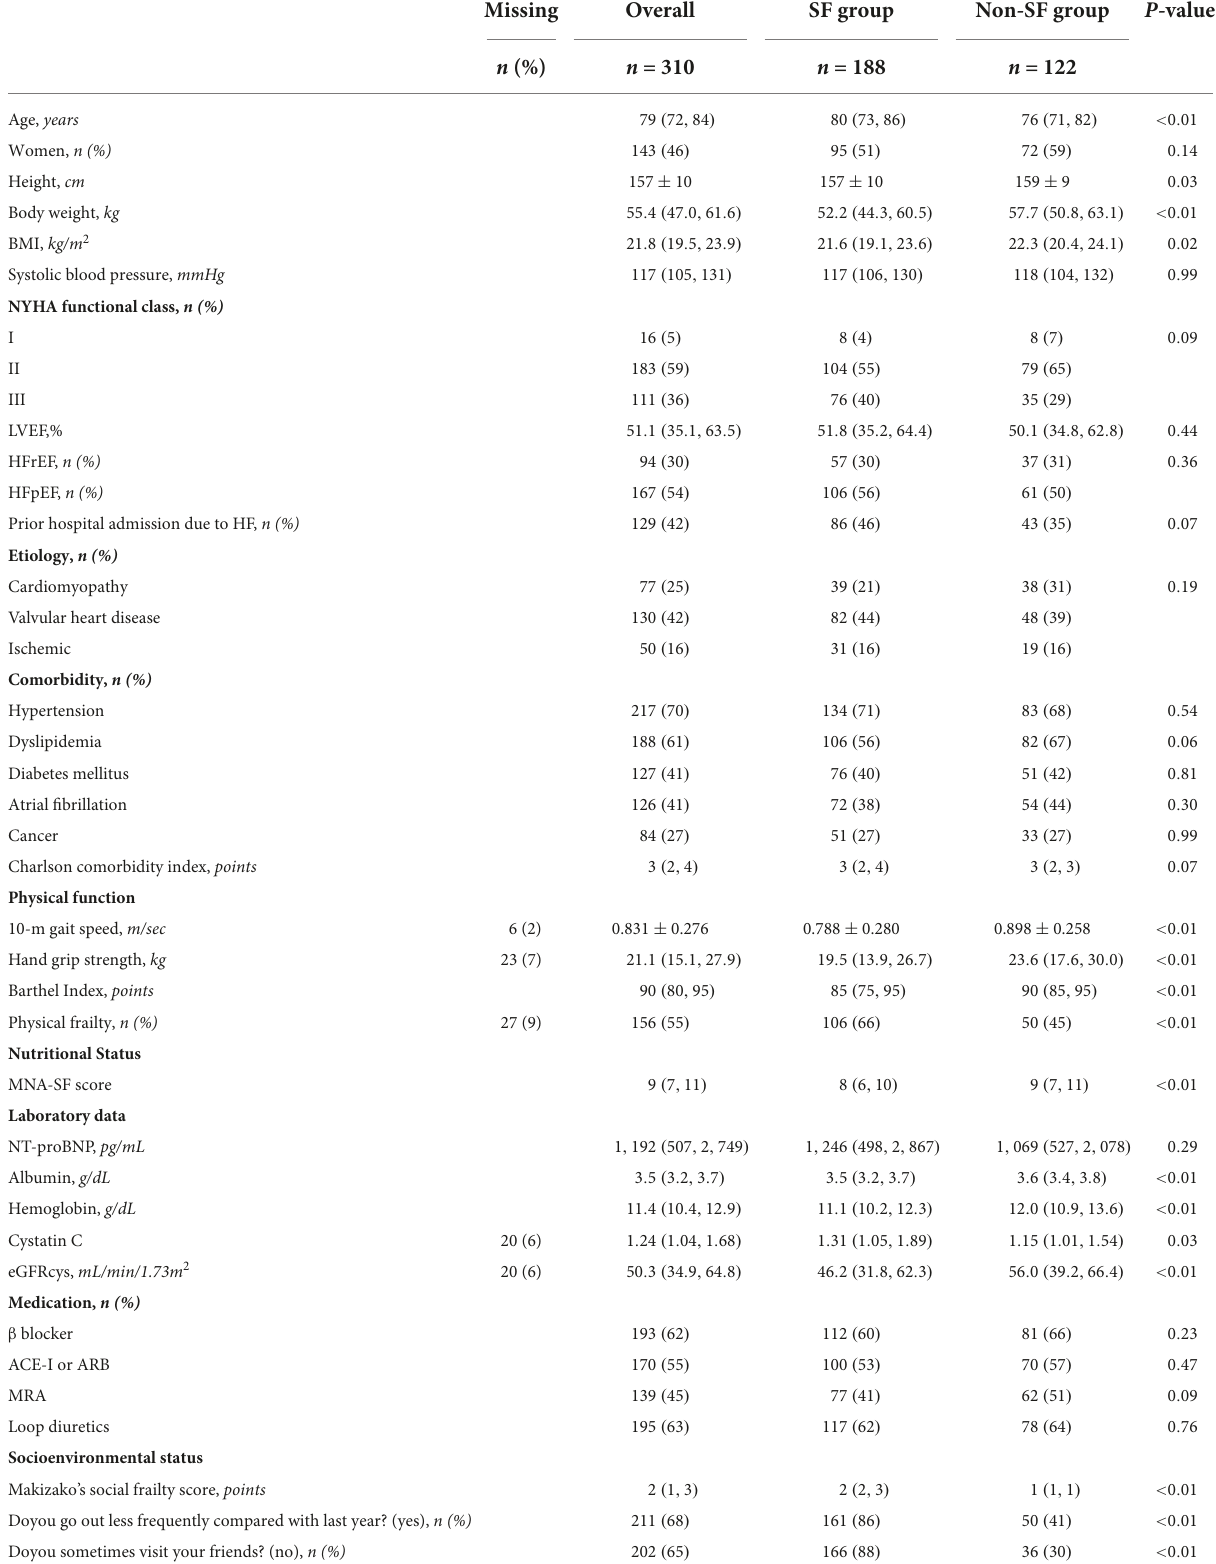
TABLE 1 Baseline